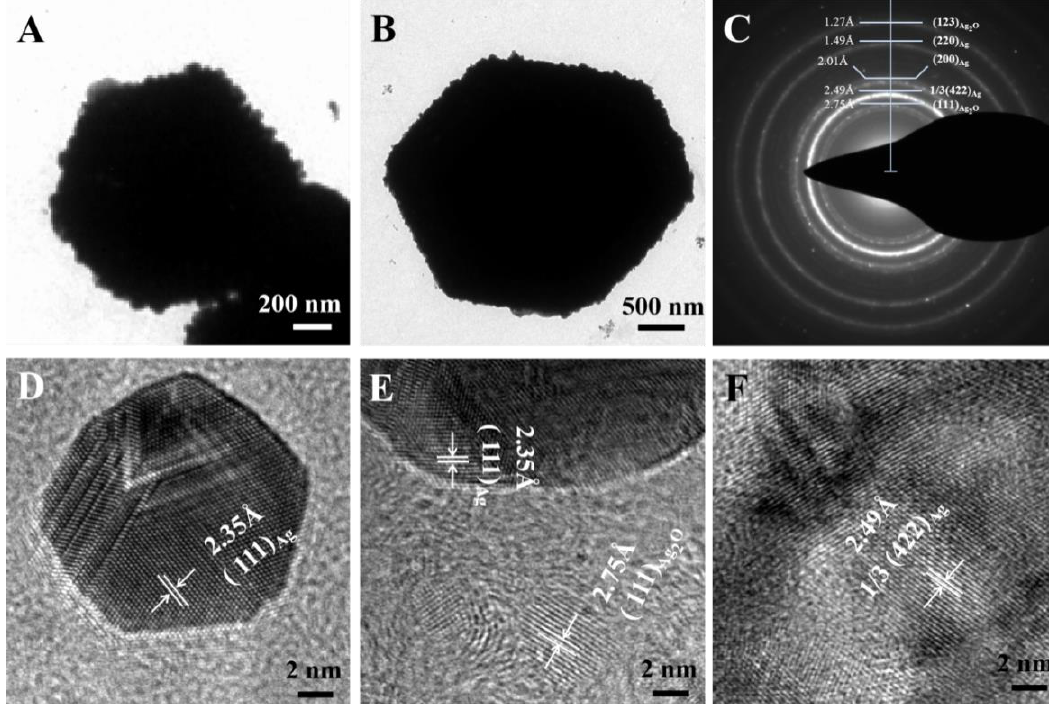
Figure 6. ( A ) TEM image of the HSANs prepared from 30 min UV-irradiation; ( B ) TEM image of HSANs prepared from 60 min UV-irradiation like rhombic dodecahedra; ( C ) selected area electron diffraction (SAED) pattern and ( D – F ) HRTEM images obtained near the edges of ( B ).